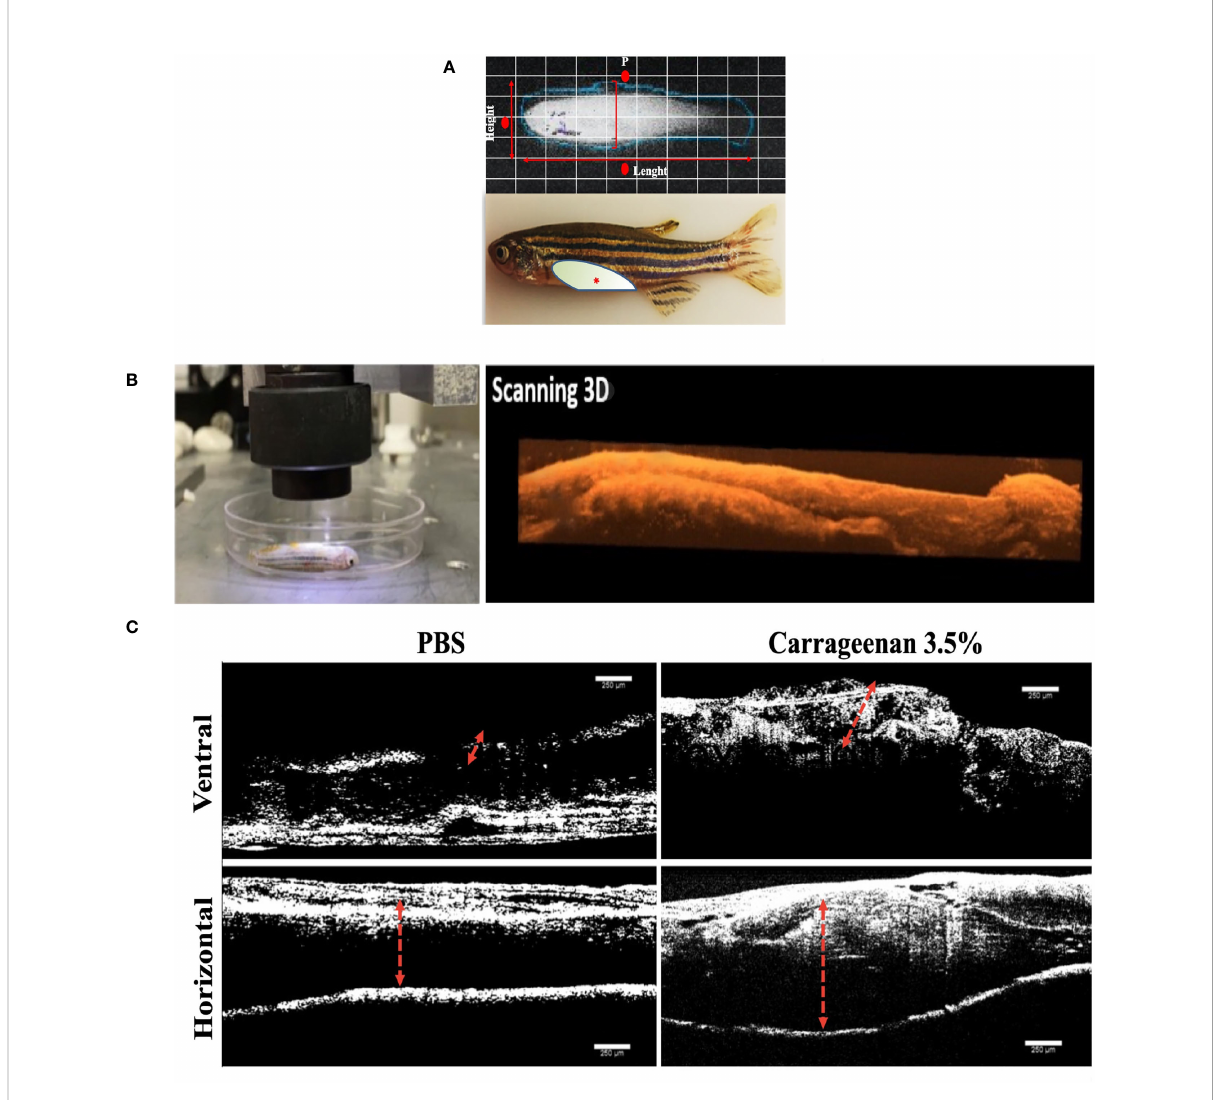
FIGURE 1 Characterization of the l -CGN-induced abdominal edema model of in fl ammation in zebra fi sh ( Danio rerio ) male adults. (A) Representative images of healthy adult zebra fi sh at the beginning of the trial. ( Upper panel ) In vivo X-ray image (Xtreme system). ( Lower panel ) Real-time image of live zebra fi sh showing the l -CGN injection site (red asterisk). The light color represents the abdominal cavity area forming edema analyzed in this study. (B) Live immobilized l -CGN-induced male zebra fi sh specimens were evaluated one by one following a side and ventral pattern using a classical optical coherence tomography (OCT) device. The representative scanning 3D reconstruction is presented on the right side. (C) Spectral domain OCT images of a healthy and in fl amed fi sh highlighting the edema boundaries and tissue disorganization (red dotted lines) on the ventral and horizontal super fi cial layers 4h post-injection of PBS or 3.5% l -CGN, respectively. Scale bar 250